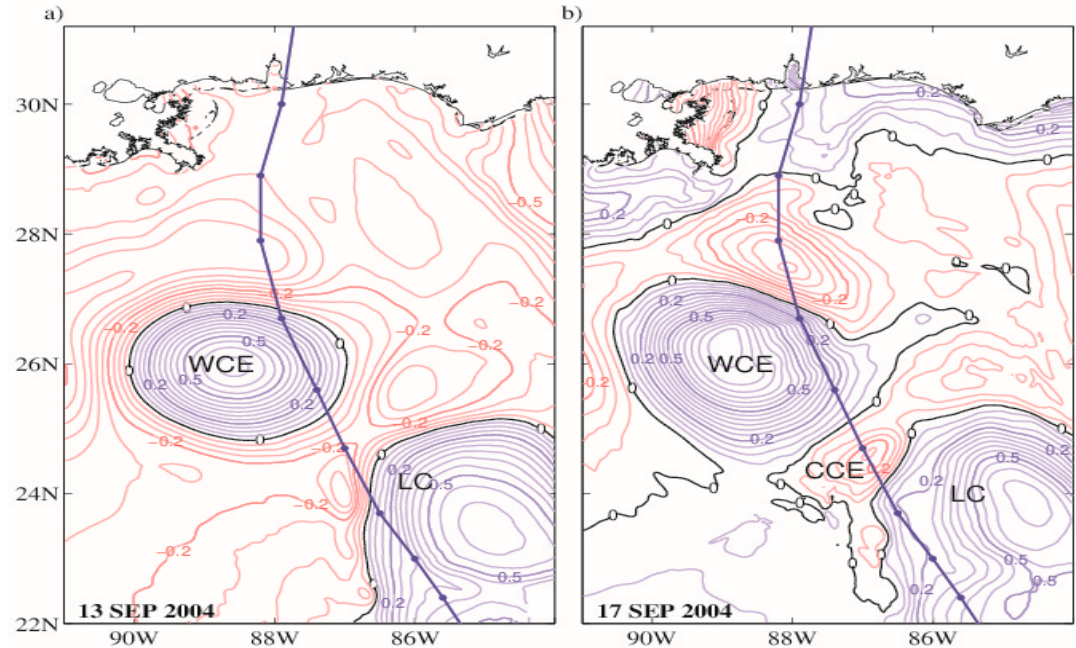
Figure 2. Sea surface height on ( a ) 13 September 2004 and ( b ) 17 September 2004. Positive SSH (purple contours) and negative SSH (red contours) are shown (0.05 m intervals). The warm core eddy (WCE), Loop Current (LC), and Cold core eddy (CCE) are labeled. Hurricane Ivan’s track is indicated by the dark purple line, with waypoints at each 0000 and 1200 UTC location. The primary track of interest is from 14 September 2004 until 16 September 2004, when Ivan entered the Gulf of Mexico and made landfall near Pensacola, FL.